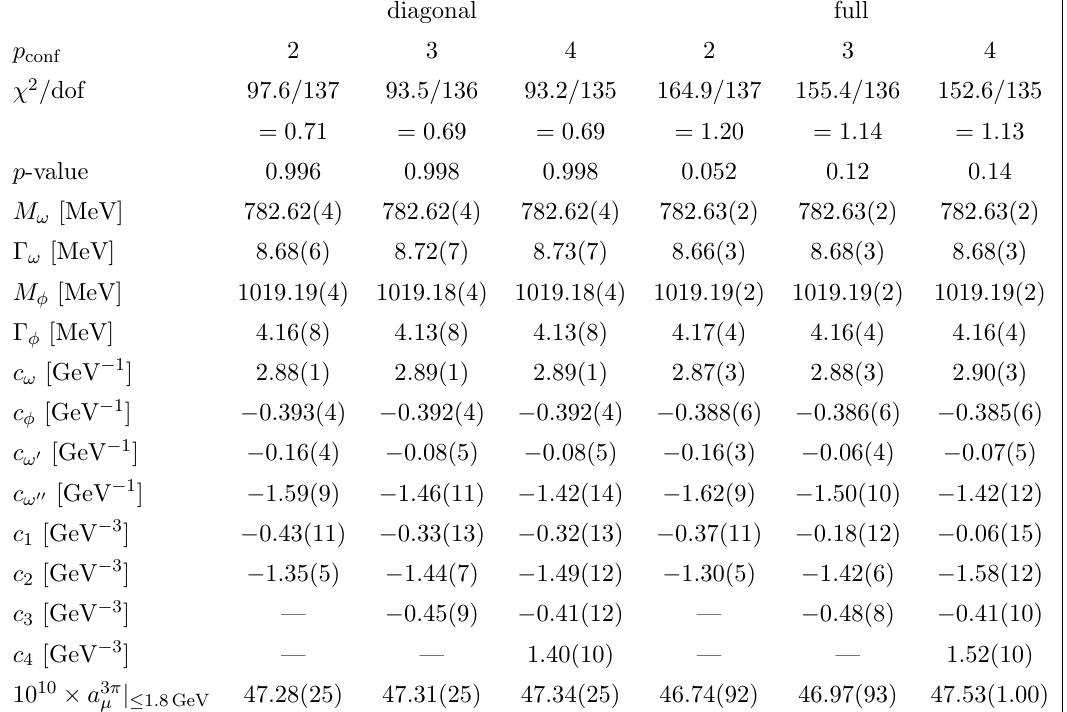
Table 2 . Fits to the combination of SND data sets [69{72], for diagonal errors and full covariance matrices. p conf denotes the number of free parameters in the conformal polynomial. All errors refer to (cid:12)t uncertainties